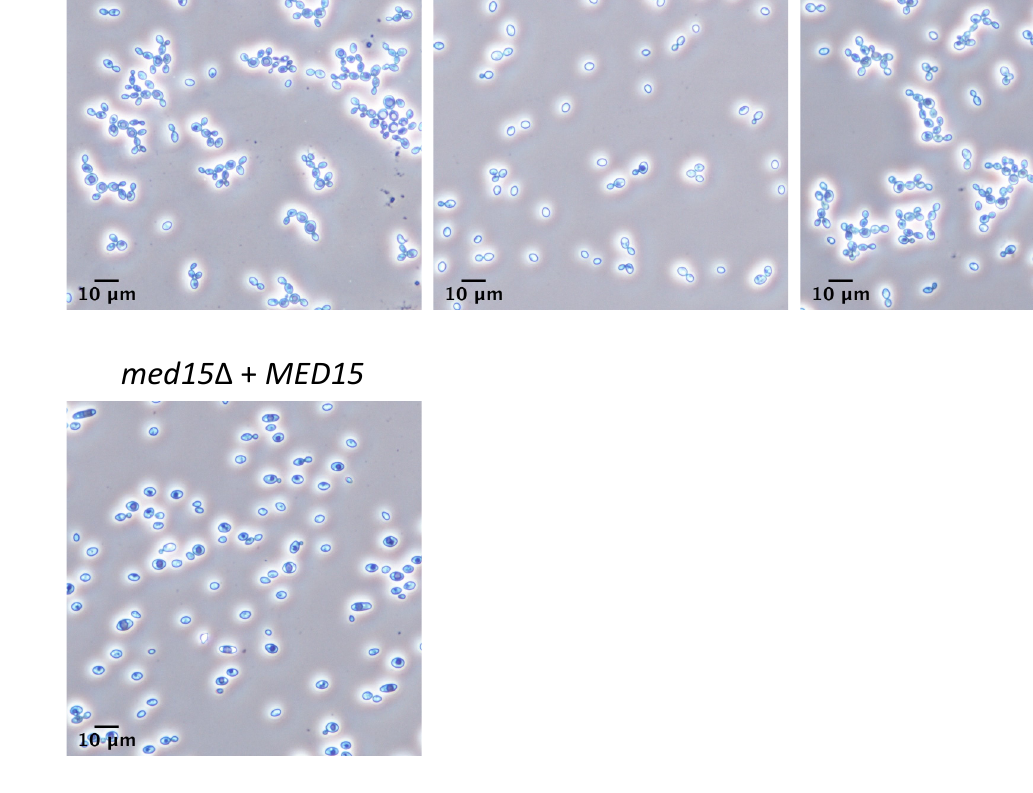
Figure 1. The cell separation defect in the dpp3 Δ mutant is due to med15 Δ mutation. WT and mutant strains of C. lusitaniae were grown in liquid YPD medium at 35 °C under 215 rpm. Cells were visualized and imaged after 48 h using 40 × magnification under brightfield. Scale bars represent 10 µ m. Please refer to Table 1 for detailed genotypes of the strains. When a WT copy a MED15 was reintegrated into the dpp3 ∆ mutant, cell separation returned to wild-type